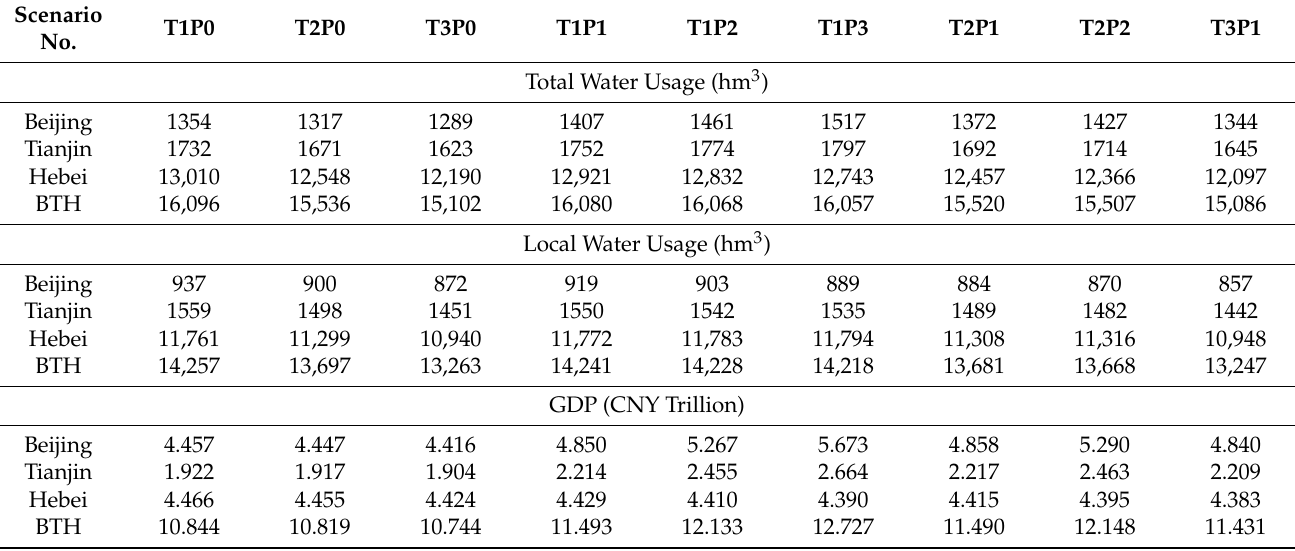
Table 3. Water usage and GDP in different